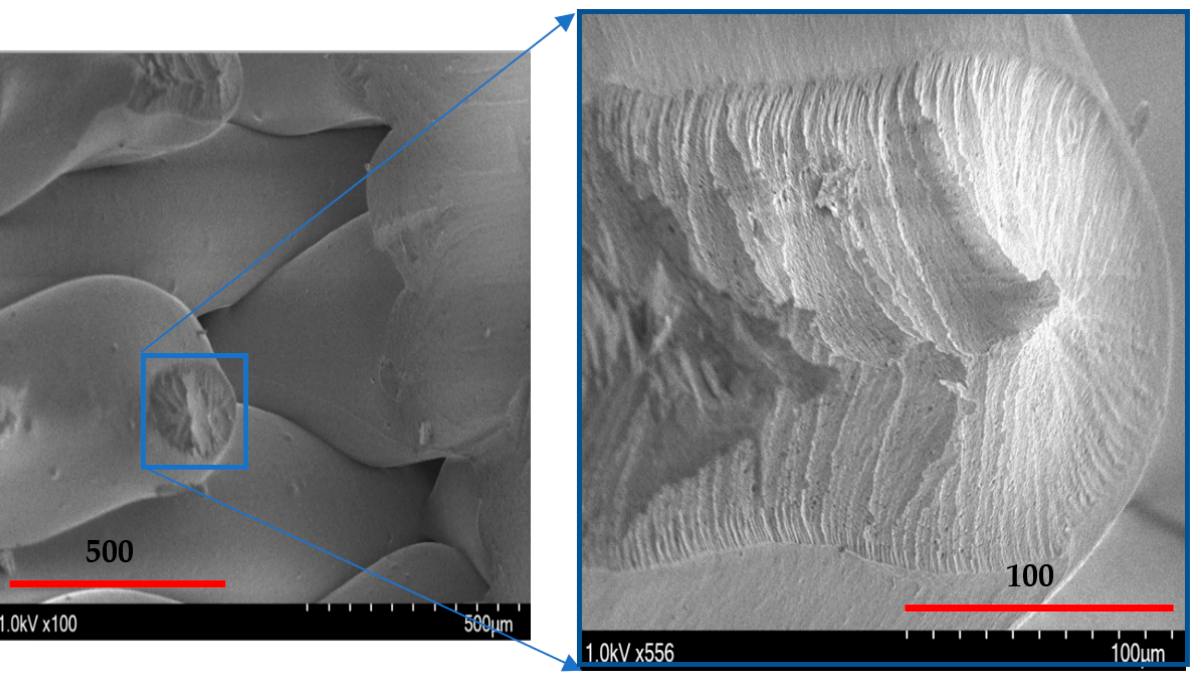
Figure 10. Scanning Electron Microscope (SEM) images of a 45/45° raster orientation, with a 5.44° notch angle specimen. (left) depicts the zoomed out and (right) depicts the zoomed in localized area of shear deformation.